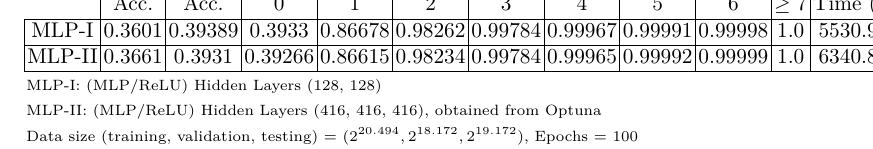
Table 3: Results for machine learning prediction (with varying tolerance) Train. Val. Testing Accuracy with Tolerance( (cid:15) ) Train. Acc. Acc. 0 1 2 3 4 5 6 ≥ 7 Time (s)